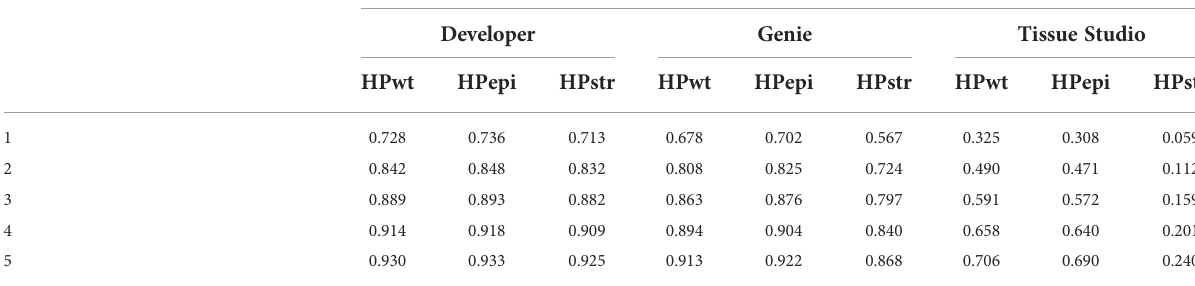
TABLE 1 Reliability of estimation of hypoxia using different platforms based on number of slides evaluated.